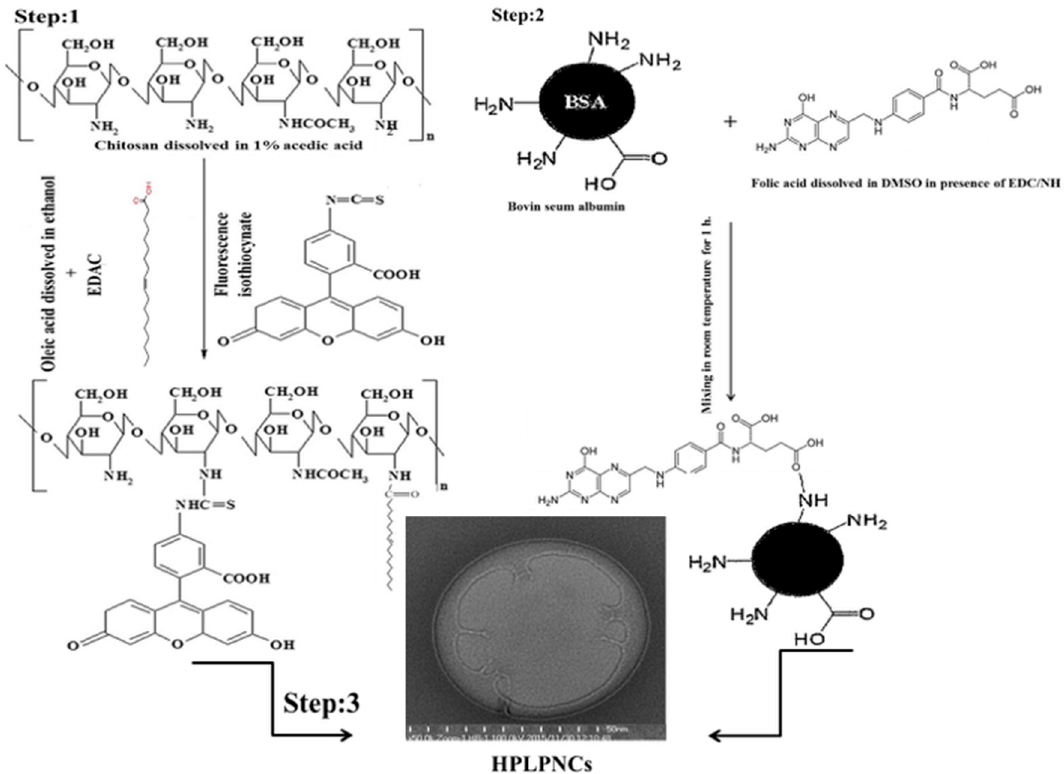
Figure 1. Scheme of hybrid polymer lipid protein nanocarrier structure. Step 1: self-assembly Structure of chitosan and oleic acid; step 2: conjugation folic acid with bovine serum albumin; and step 3: functionalization of chitosan grafted oleic acid surface by using BSA-FA.